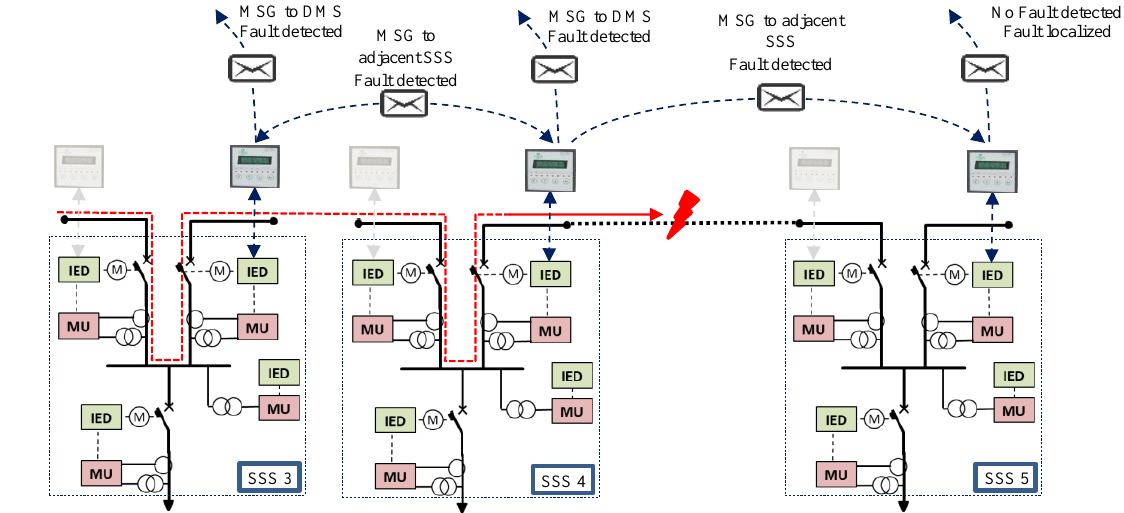
Figure 5. Short circuit current direction during three-phase fault in radial network.